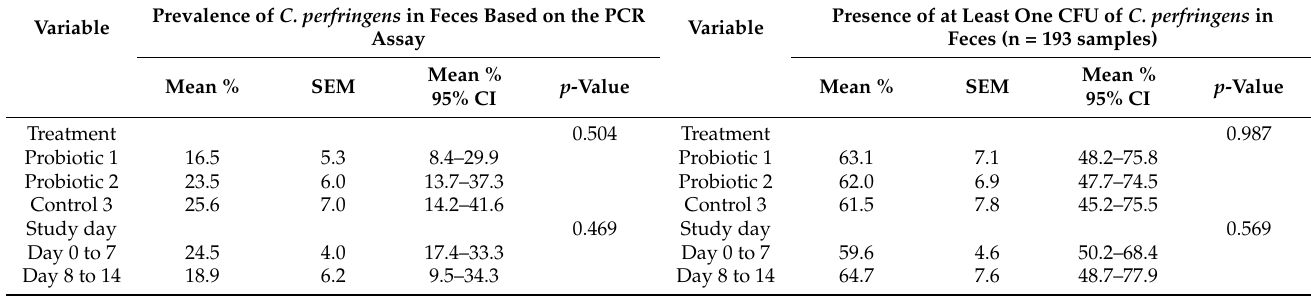
Table 4. Prevalence of C. perfringens in feces based on PCR (dichotomous outcome) and concentration of bacteria in feces (modeled as dichotomous and continuous outcome) estimated from multivariable models a